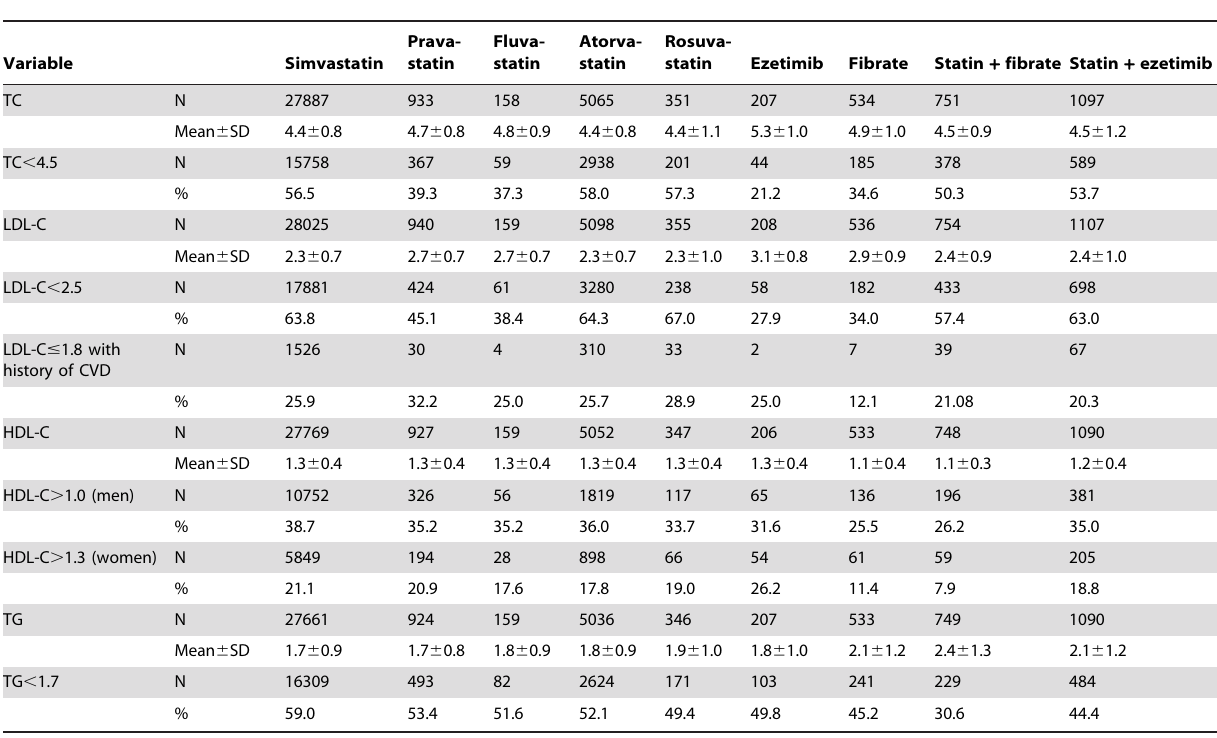
Table 3. Blood lipid values of the patients on lipid lowering treatment 2008.